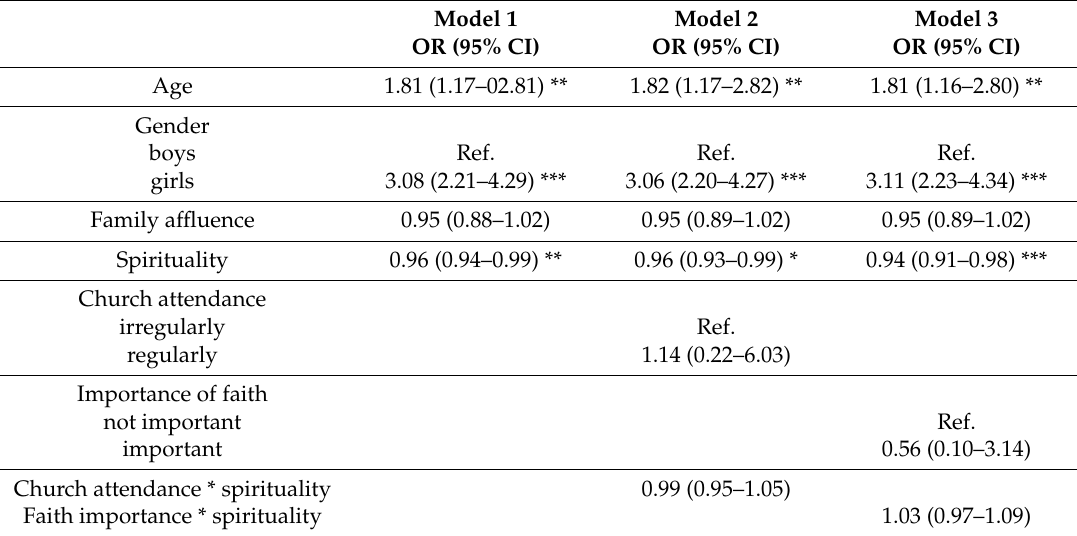
Table 3. Logistic regression with ORs and 95% CI of the association between spirituality and